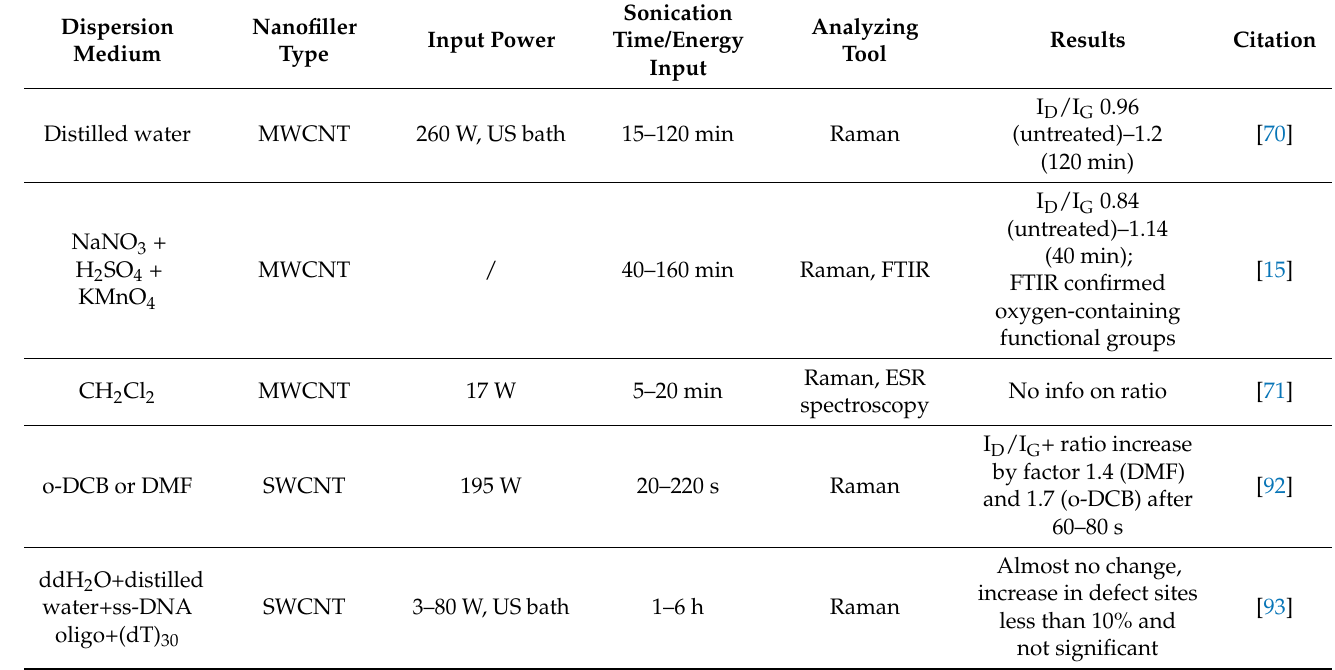
Table 3. Overview of the literature with respect to surface damage determined by Raman spectroscopy, including solvent system, type of CNT, input power, and sonication time, together with reported effect and the respective